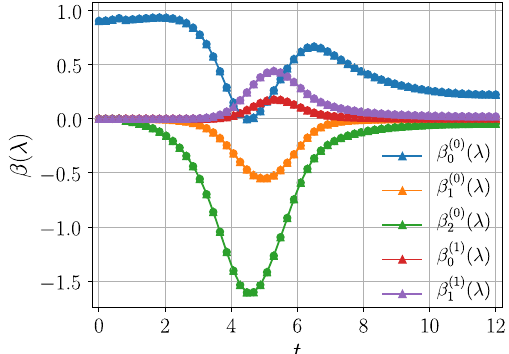
FIG. 15. Spin-1 Ising chain: time dependence of the optimal k Þ λ ð t ÞÞ in the variational gauge potential [Eq. (E6)] coefficients β ð l ð with translation and reflection symmetry, determined from the procedure in Appendix E 2. The total duration T ¼ 12 with the time discretization step Δ t ¼ 0 . 2 , and the system size N ¼ 8 . The protocol we use is λ ð t Þ ¼ sin 2 ð π t= 2 T Þ . The other model param- eters are the same as in Fig. 7.